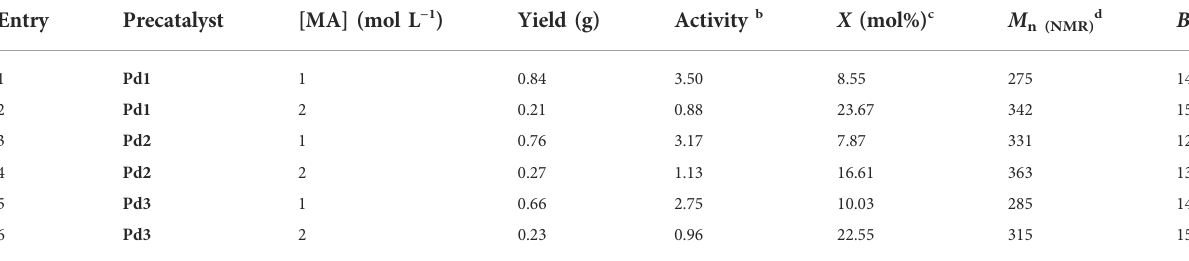
TABLE 3 Co-oligomerization of methyl acrylate and ethylene with Pd(II) catalysts a